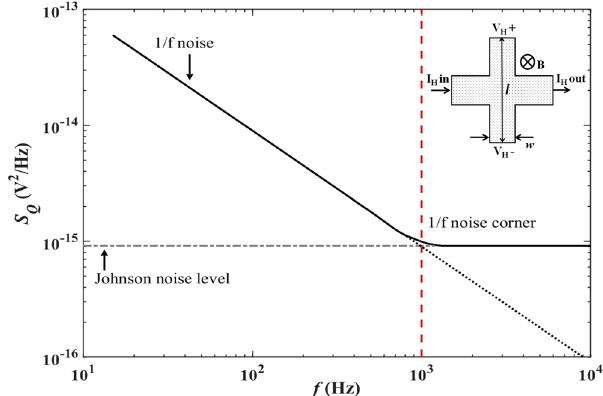
Figure 1. Schematic frequency dependence of the noise power in Hall devices with extrapolated lines indicating the behaviour of Johnson noise and 1/f noise below and above the 1/f noise corner. The inset shows a sketch of a typical Hall cross indicating the current leads, Hall voltage leads and their